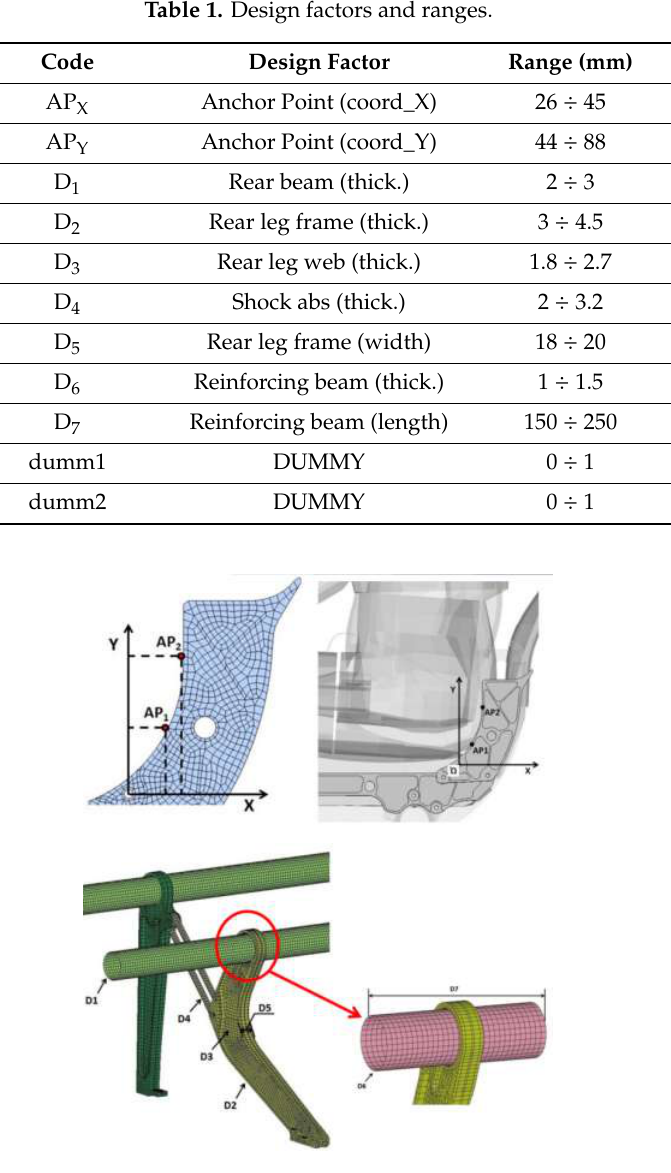
Figure 8. Design Figure 8. Design factors.